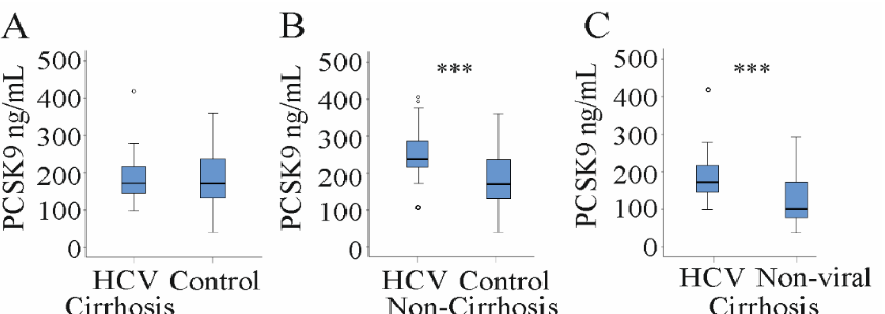
Figure 3. Serum PCSK9 in controls, non-cirrhotic HCV patients and cirrhotic patients with HCV or non-viral disease eti- ology. ( A ) Serum PCSK9 of HCV patients with liver cirrhosis and controls not infected with HCV; ( B ) Serum PCSK9 of HCV patients without liver cirrhosis and the controls not infected with HCV; ( C ) Serum PCSK9 in patients with HCV and non-viral liver cirrhosis. Small circles above or below the boxes mark outliers. *** p < 0.001.